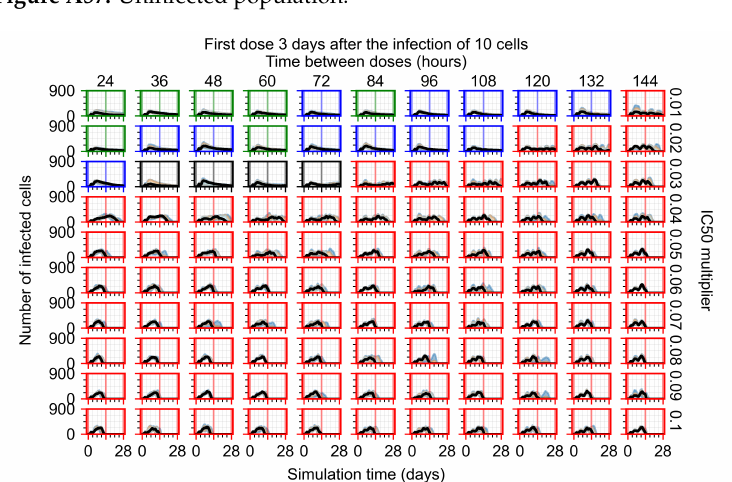
Figure A57. Uninfected population.